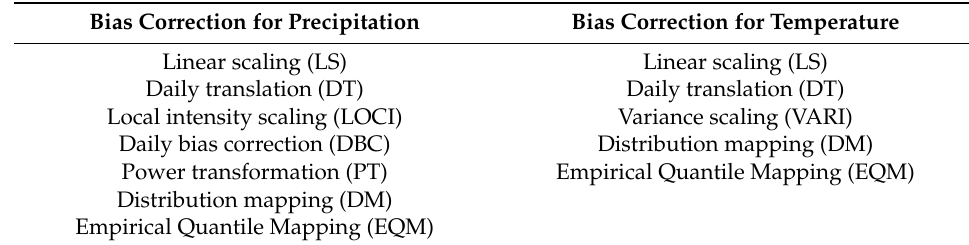
Table 1. Bias correction methods for precipitation and